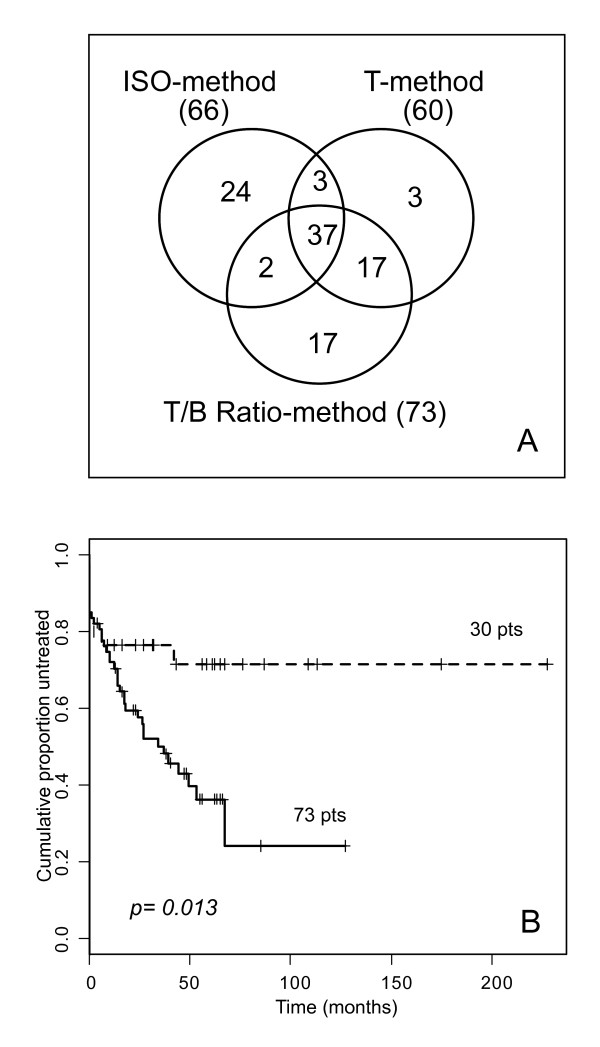
Analysis of ZAP-70 concordant and discordant cases among ISO-, T- and T/B Ratio-methods (test set). (A) Venn diagram depicting concordant and discordant cases, as obtained by merging the ZAP-70 positive cases determined by ISO-, T- and T/B Ratio-methods. (B) Kaplan-Meyer curves obtained comparing TTT of patients affected by CLL expressing ZAP-70 according to T/B Ratio-method (73), or expressing ZAP-70 according to either ISO- or T-methods (30).